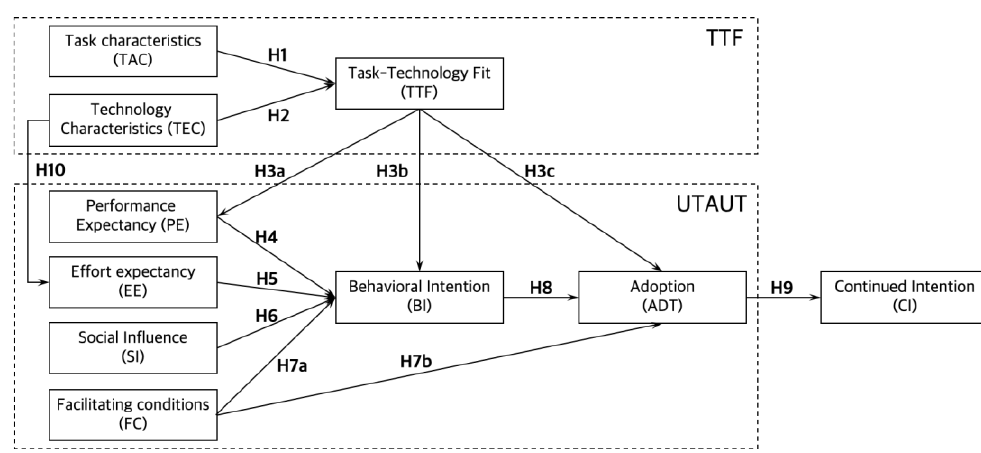
Figure 1. Theoretical framework (TTF: task technology fit, UTAUT: unified theory of acceptance and use of technology).